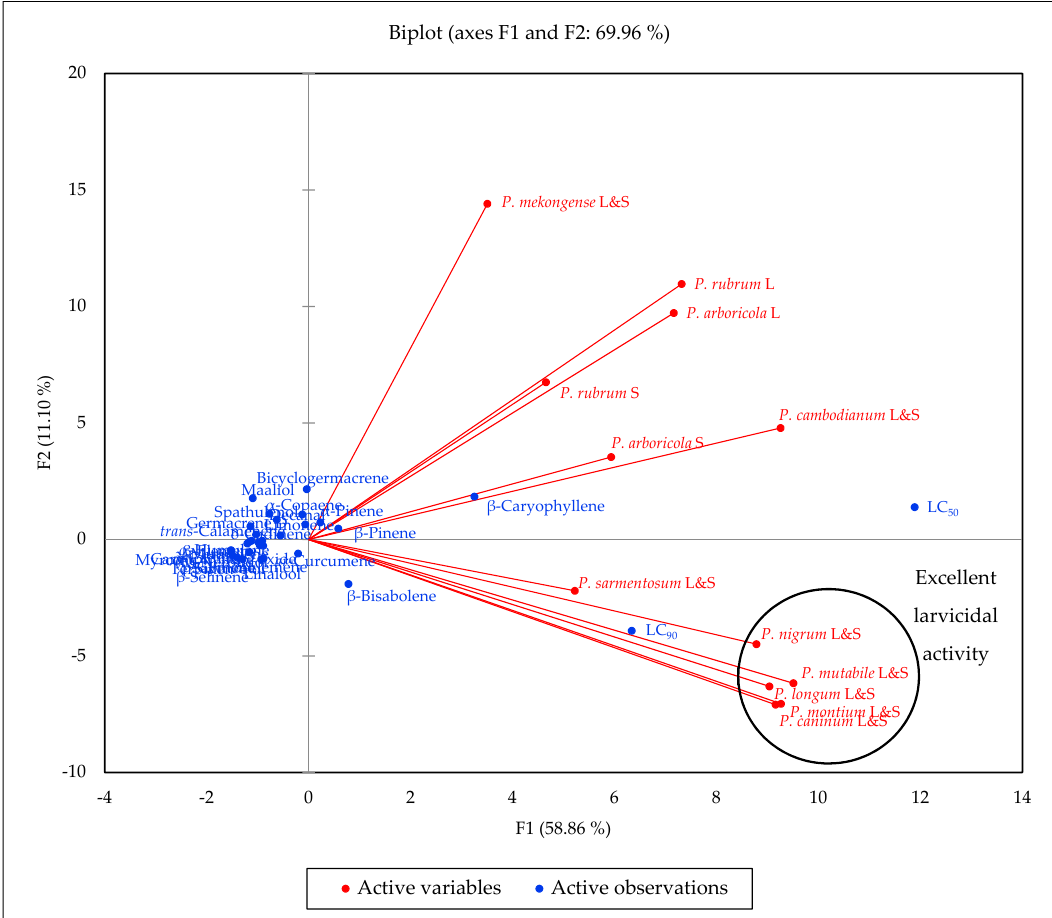
Figure 3. Principal component biplot of PC1 and PC2 scores and loadings indicating the correlation of chemical components of Piper essential oils from central Vietnam and Aedes aegypti larvicidal activity.